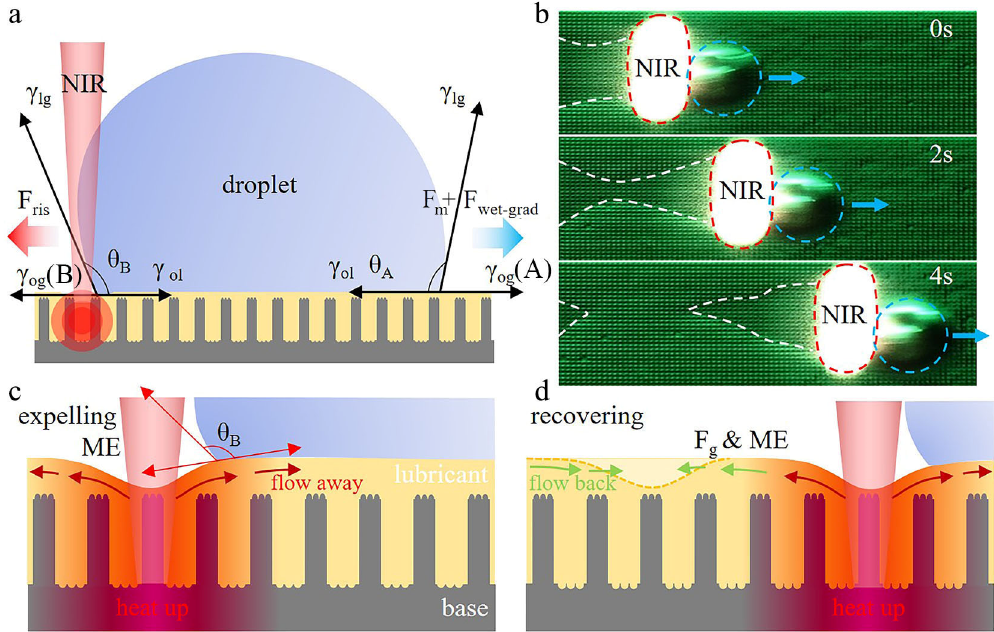
Figure 5. Mechanism of HD-PTSS in droplet manipulation. ( a ) Force analysis of droplet with NIR stimulus. ( b ) Expelling and recovering of silicone oil layer in droplet transportation. ( c , d ) Schematic of silicone oil layer motion with NIR